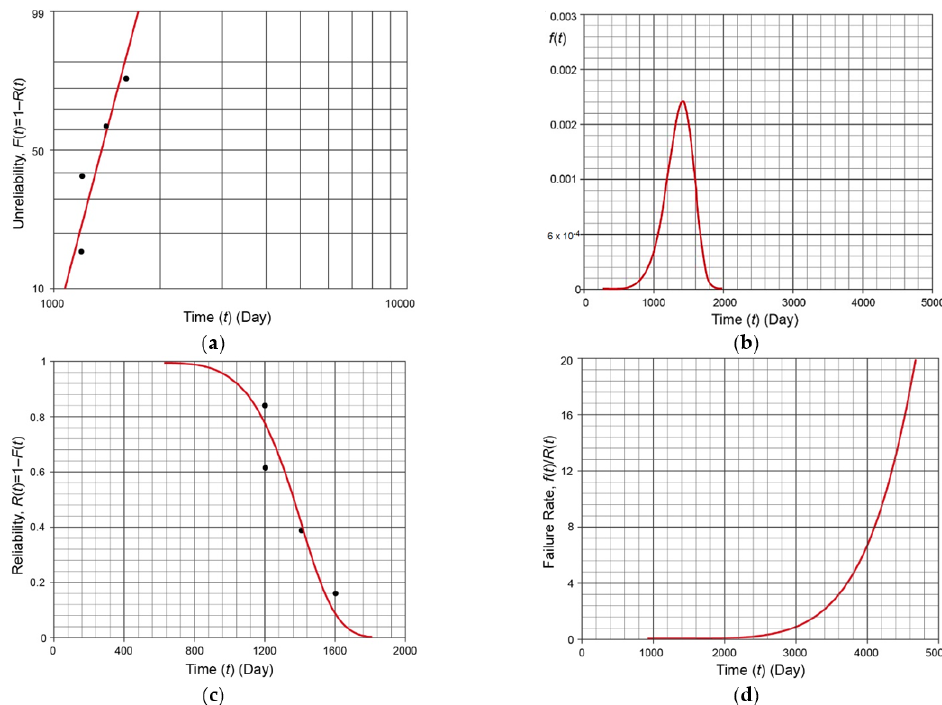
Figure 3. Reliability analysis of observed failures: ( a ) Weibull diagram of the unreliability of the analyzed damage population; ( b ) probability density function of the analyzed damage population; ( c ) the graph of the function of the reliability of the analyzed manholes; and ( d ) the graph of the function of the failure rate for the analyzed